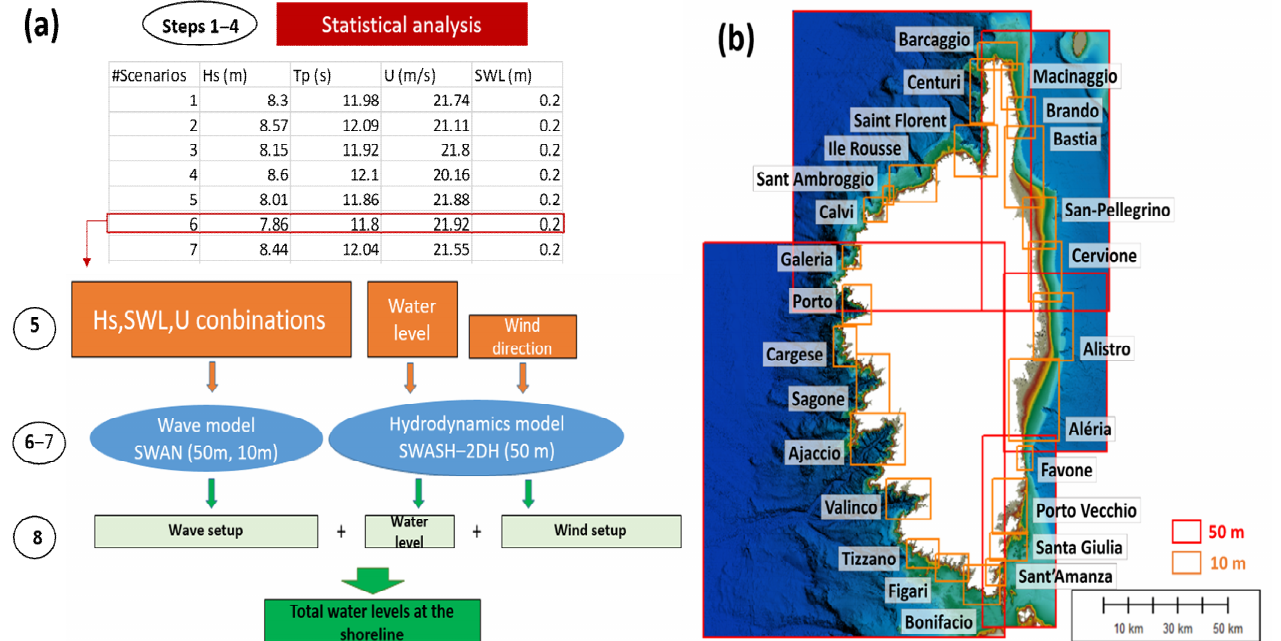
Figure 2. ( a ) Recap of our multivariate extreme value analysis. ( b ) Nested boxes used all around Corsica Island for the numerical simulations; 50 m resolution grids are in red and 10 m resolution boxes are in orange.